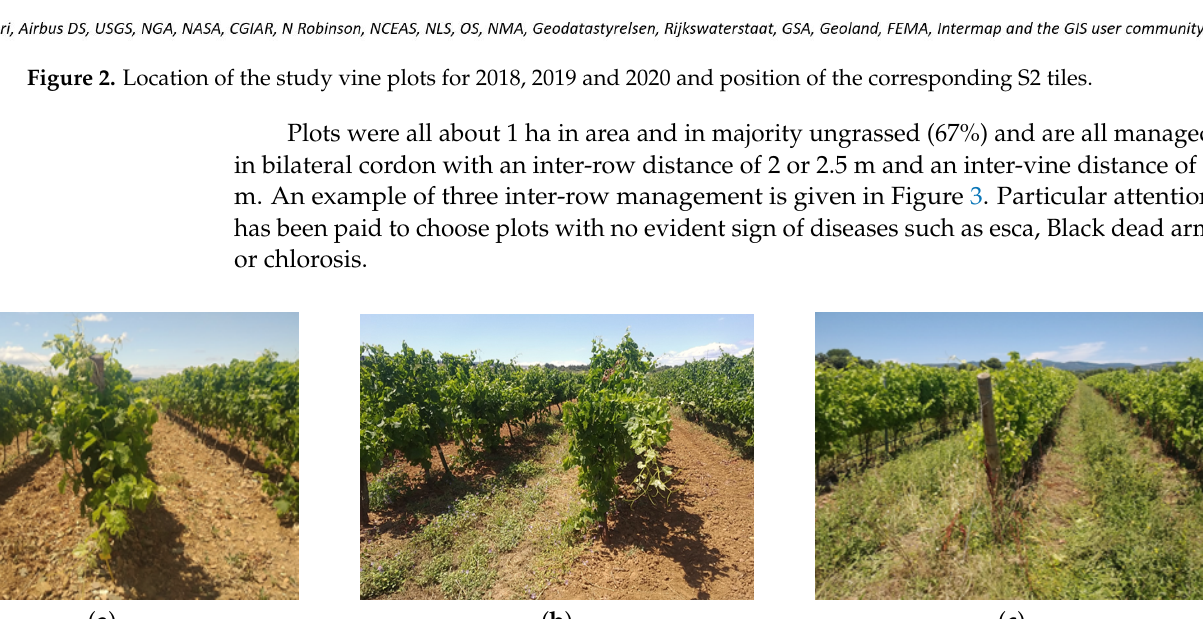
Figure 3. Inter-row management example. ( a ) Plot ungrassed. ( b ) Plot with grass one row on two. ( c ) Plot totally grassed. Our study spans over three years with different types of vintage being